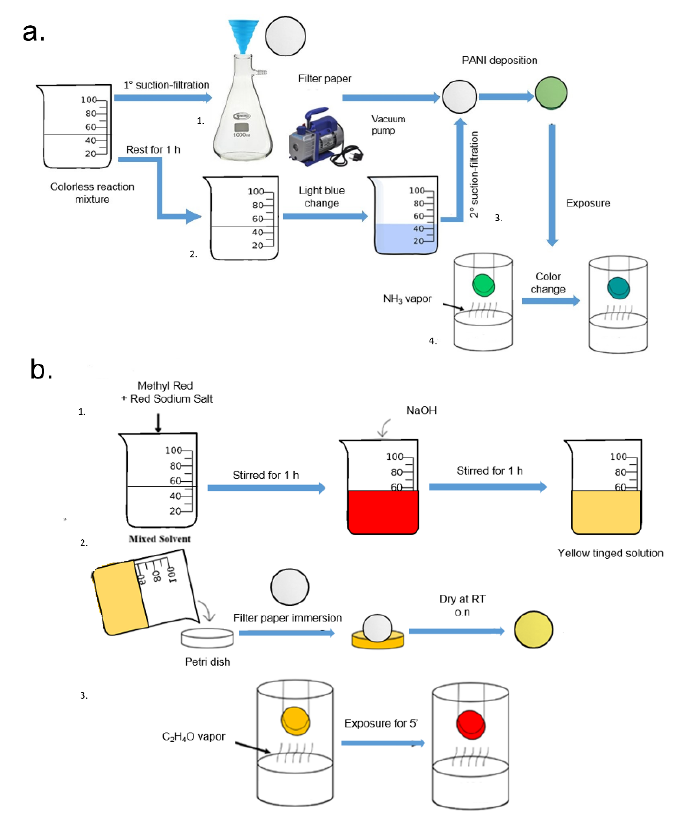
Figure 1. Schematic NH 3 (a) and C 2 H 4 O (b) paper sensor fabrication procedure : ( a ) 1 . Half of the colorless reaction mixture was immediately suction-filtered into a silicon funnel where a filter paper ( white circle ) was placed. 2. The remaining part of the solution was left to stand for 1 h. During this time, the solution turned light blue. 3. The solution was filtered (II suction-filtration) through the filter paper, in order to induce the polyaniline (PANI) deposition. After several washes and air flow drying, the formation of emerald green filter paper ( green circle ) was completed. 4 . The emeraldine green filter paper turned into a blue emeraldine base ( blue circle ) as a result of NH 3 vapor exposure. ( b ) 1. The methyl red and methyl red sodium Salt were added to the mixture. The color solution turned into red-orange and was stirred for 1 h. After this time, NaOH was added, resulting in a color change to yellow. The solution was left to stand for 1 h. 2 . The solution was transferred in a petri dish and the filter paper was immersed in it for 1 h. The filter paper was dried overnight in the dark at room temperature. The formation of methyl red filter paper ( yellow circle ) was completed. 3 . The methyl red filter paper turned into red ( red circle ) as a result of C 2 H 4 O vapor exposure.